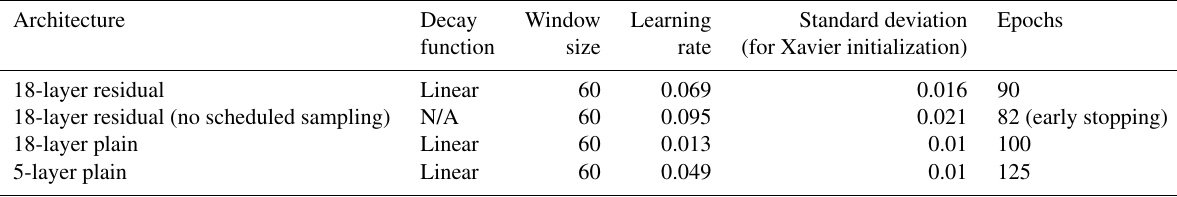
Table A1. Hyperparameters for each network architecture used in this study (see Table 1). For each architecture, we tuned the learning rate, standard deviation used for weight initialization (sampling from a truncated normal distribution), and number of training epochs (unless training without scheduled sampling, in which case we used early stopping with a patience threshold of 10). For each architecture, the optimal hyperparameter configuration was selected after 60 iterations of random search.